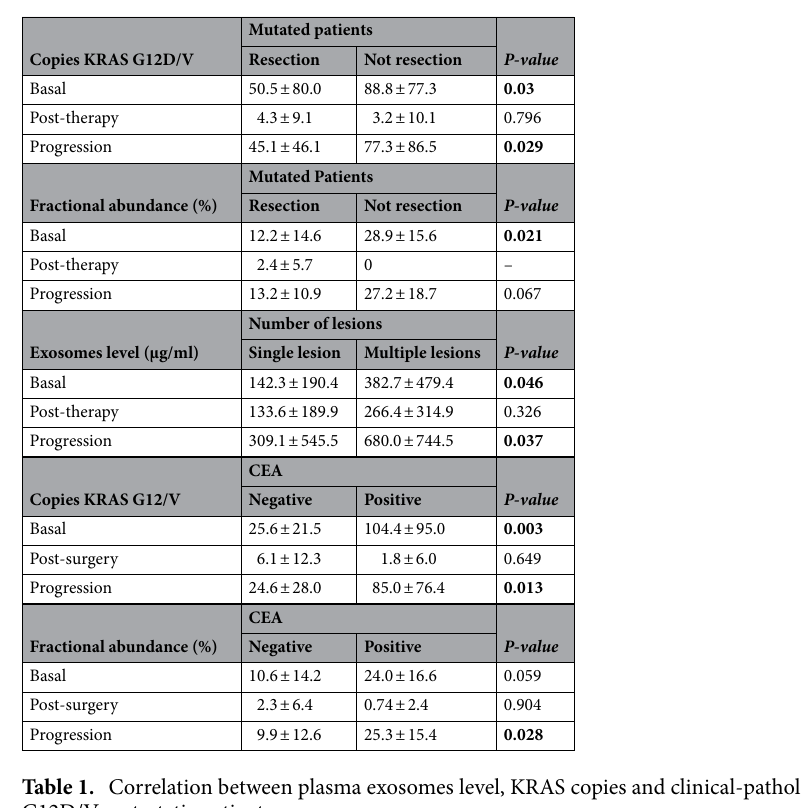
Figure 1. Evaluation of plasma exosomes levels correlated with clinical features of patients. ( a ) The graph show exosomes levels in patients with localized primary tumor (n = 29) compared to metastatic patients (n = 70); ( b – d ) evaluation of exosomes levels in three different subsets of patients: all metastatic patients (n = 70), KRAS wild type (n = 35) and KRAS G12D/V mutated (n = 35); ( e ) the graph shows the correlation of exosomes levels of mutated patients with the presence of single (n = 6) or multiple lesions (n = 29) metastasis. ( f ) Trend of mean level of exosomes isolated from metastatic patients undergoing surgery (n = 22) at different time points from the day before start of therapy. ( g , h ) comparison among exosome concentration in metastatic patients undergoing surgery at basal, post-therapy and progression time point. ( i ) stratification of exosomes level in CRC metastatic patients candidate to surgery according to the radiological response (n = 5 for stable response; n = 17 for partial response).